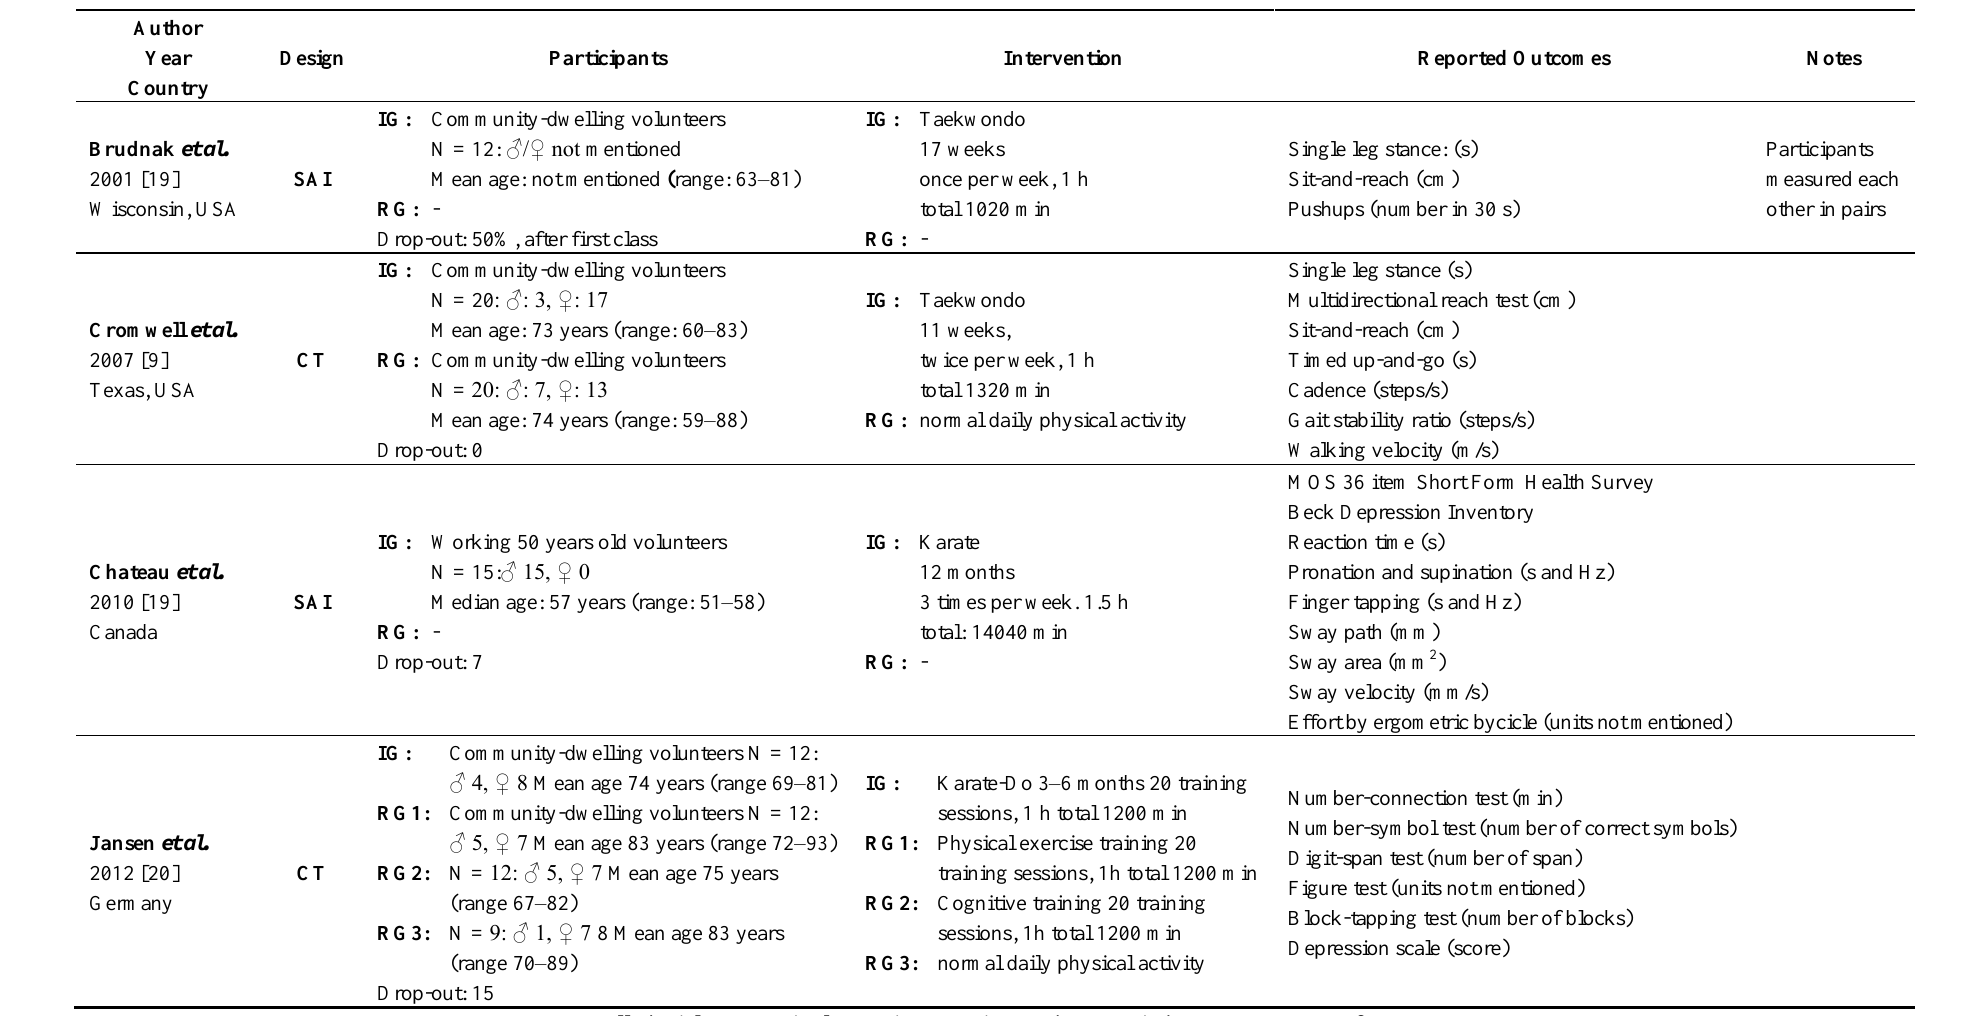
Table 1. Characteristics of included